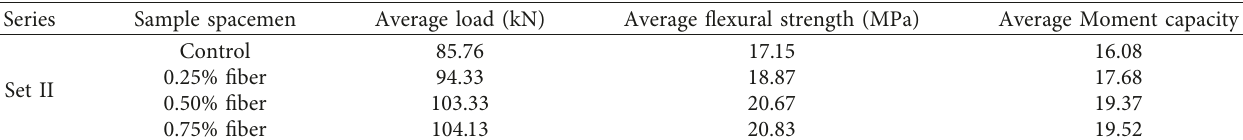
Table 6: Average failure load, moment, and flexural strength of concrete beam samples after 28-days reinforced with glass fiber and reinforced bar.